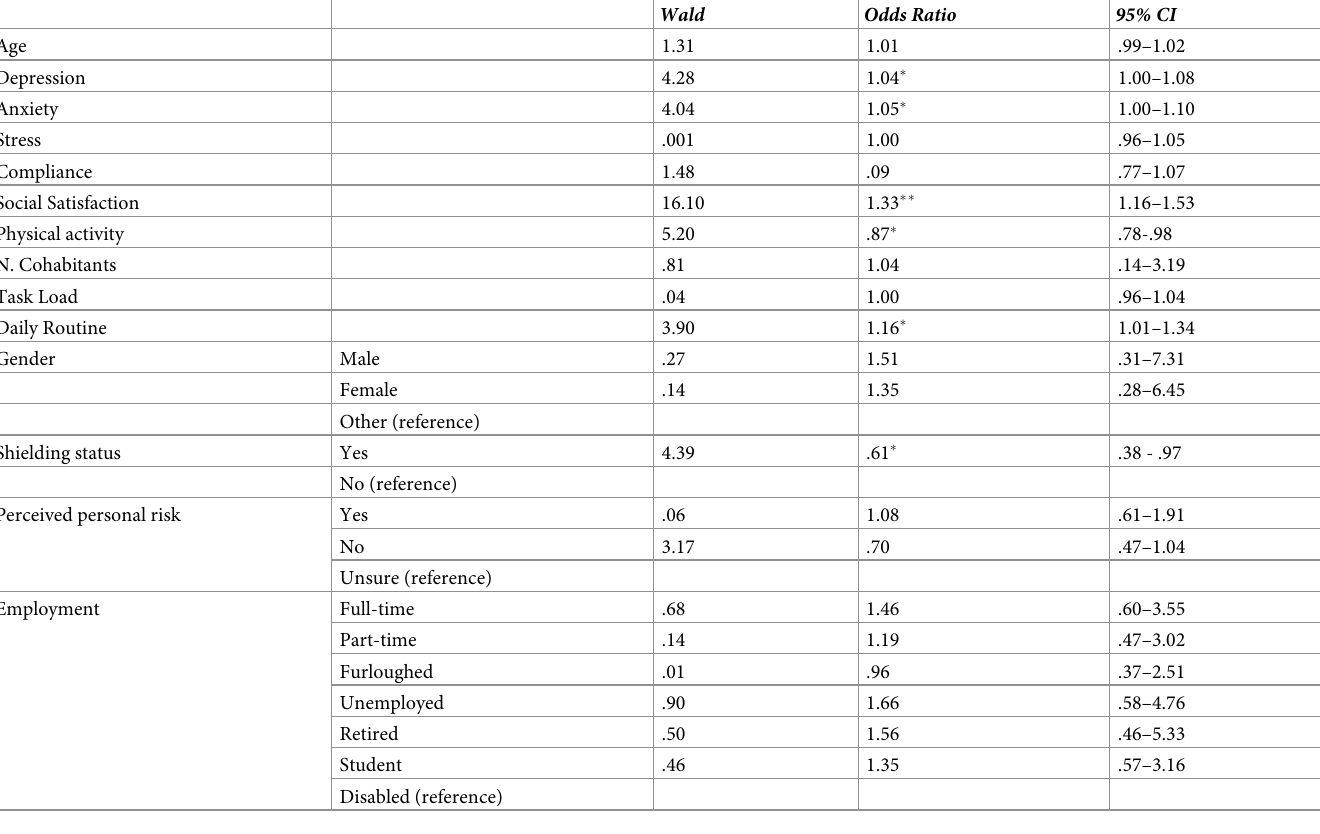
Table 3. Ordinal logistic regression with odds ratio (and 95% of confidence intervals) with subjective length of the preceding 12 months as outcome and age, depres- sion, anxiety, stress, compliance, social satisfaction, physical activity, number of cohabitants, task load, daily routine, gender, shielding status, covid perceived risk and employment status as